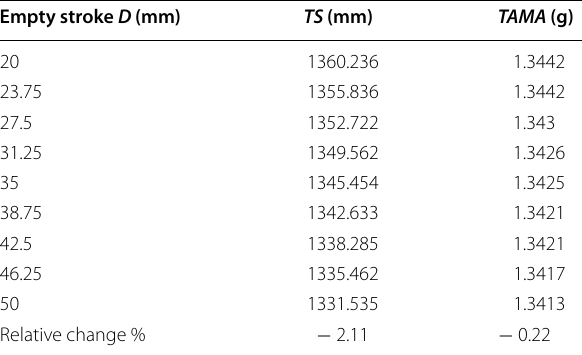
Table 5 Responses of TS and TAMA under different D Empty stroke D (mm)